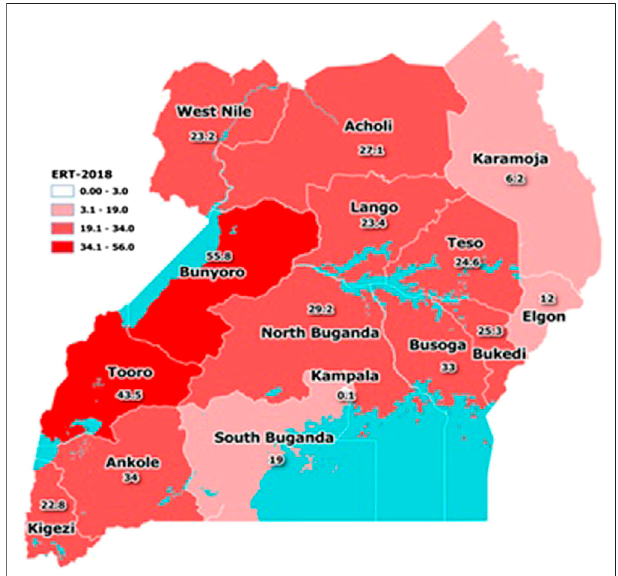
FIGURE 1 | Spatial distribution of solar PV by sub-region in 2018 (Source: Authors ’ calculation based on National Electri fi cation Survey